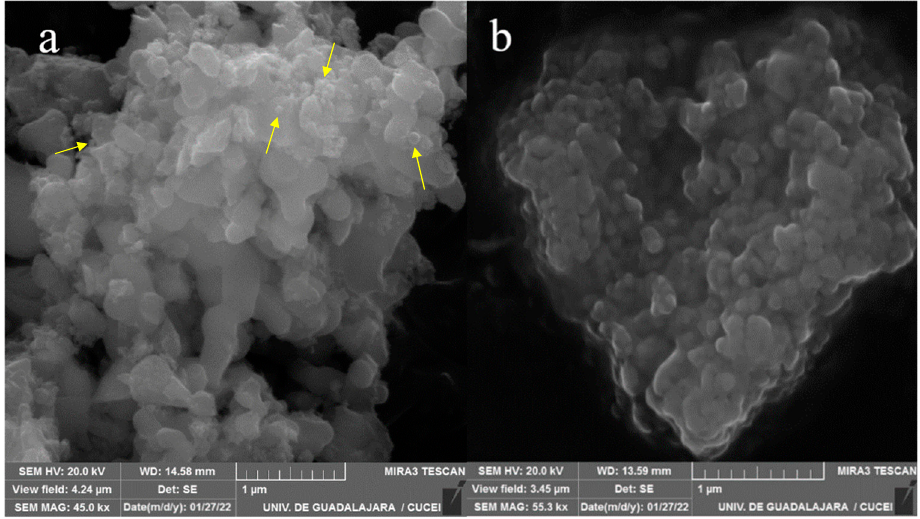
Figure 1. Micrographs of nanoparticles. (( a ): TiO 2 NP, ( b ): PLGA-TiO 2 ).